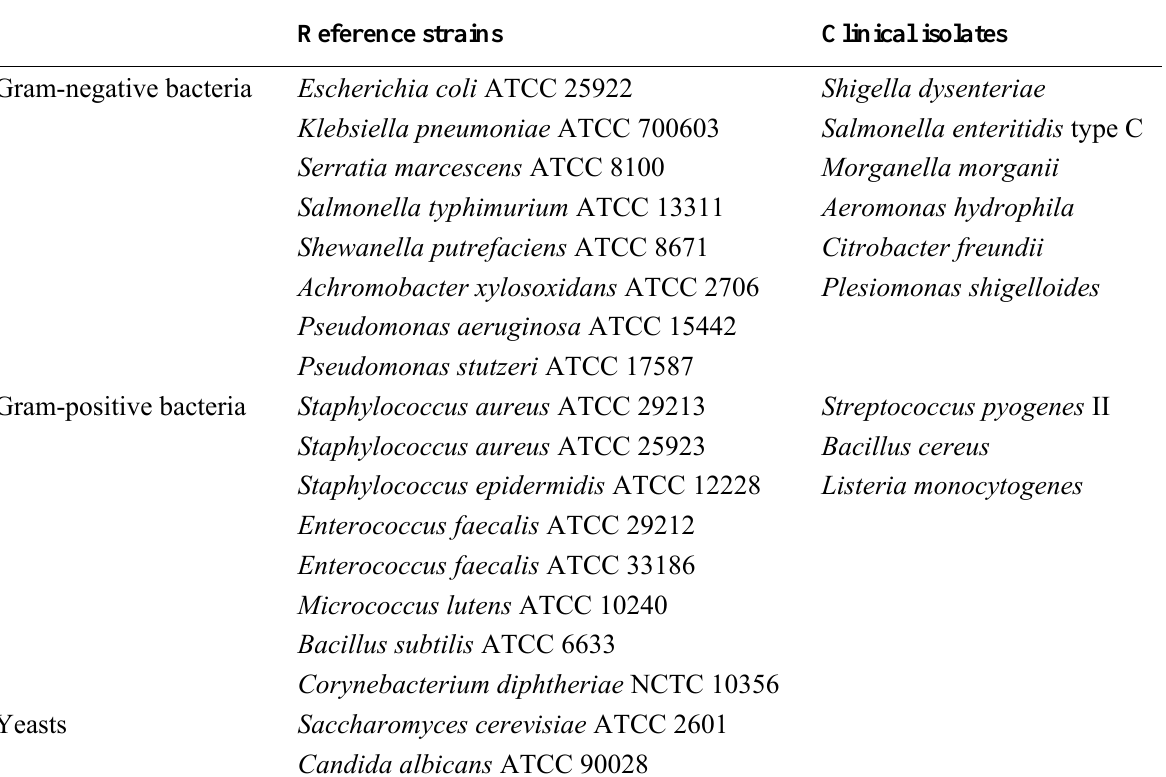
Table 4 . The twenty-seven strains of microorganisms used for antimicrobial activity